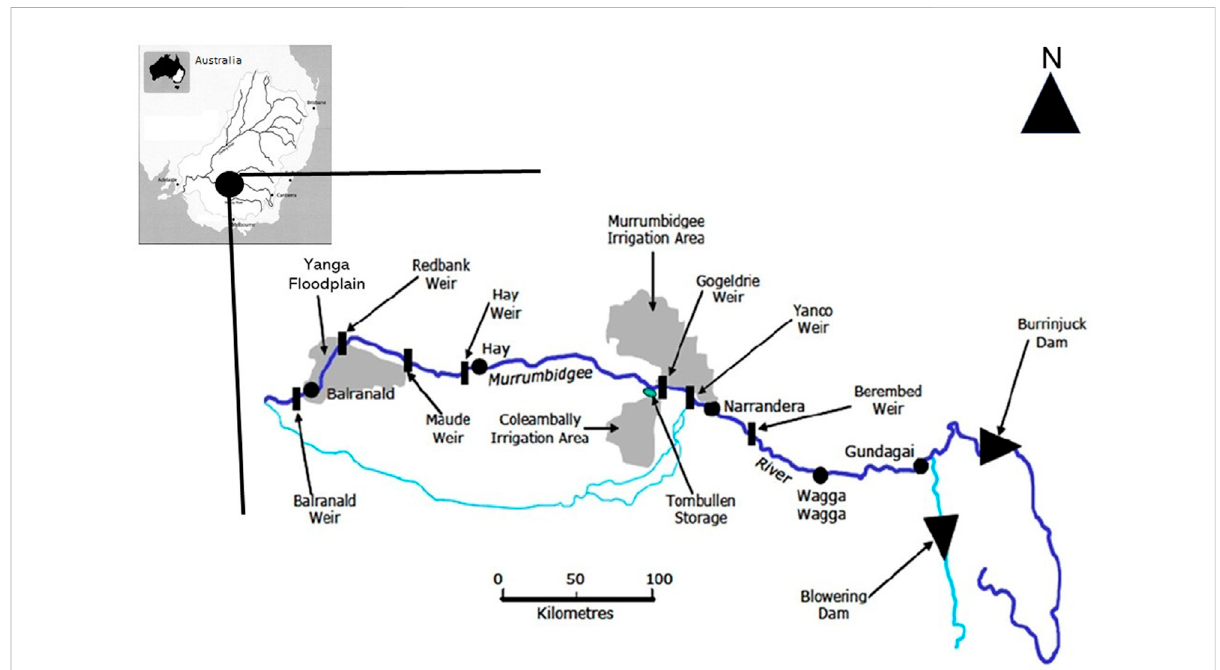
FIGURE 2 The Murrumbidgee River system and Yanga fl oodplain landscape within the Murray Darling Basin in southeast Australia. Main tributaries and anabranchchannelsshowninlightblue.Signi fi cantwaterresourceinfrastructureandtheYanga fl oodplain(Lat:34.6172 ° S;Long:143.6392 ° E)arealso